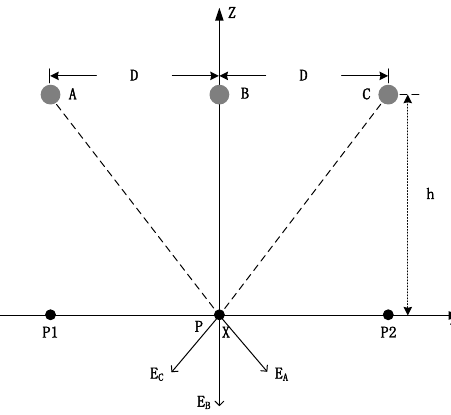
Figure 21. Horizontal arrangement of a three-phase line.